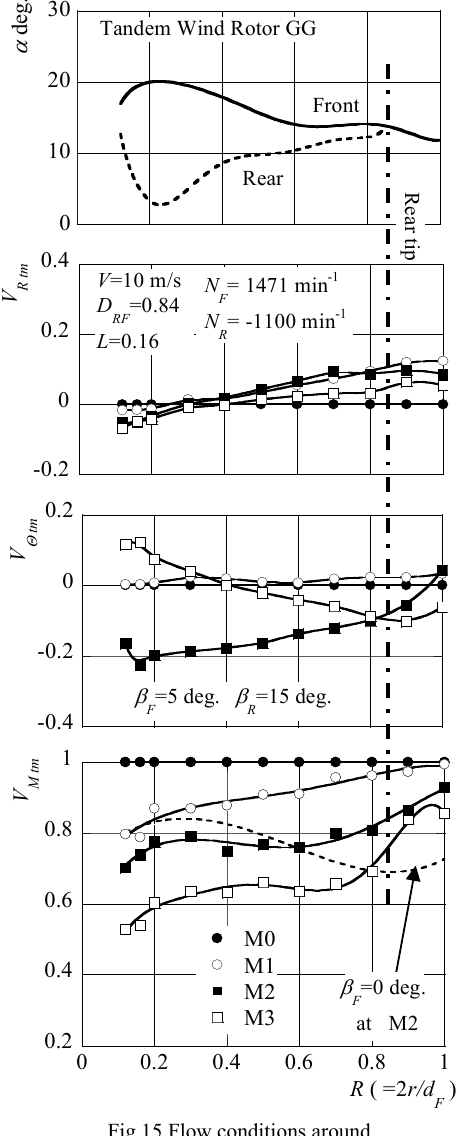
Fig.15 Flow conditions around Tandem Wind Rotor